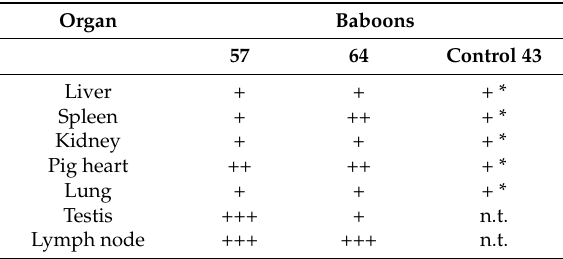
Table 3. Results of the immunohistochemistry (IHC) analysis of different organs from two baboons after pig heart transplantation and one control baboon.